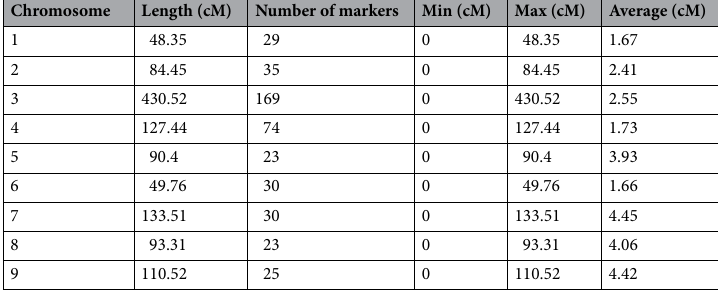
Length (cM) Number of markers Min (cM) Max (cM) Average (cM)